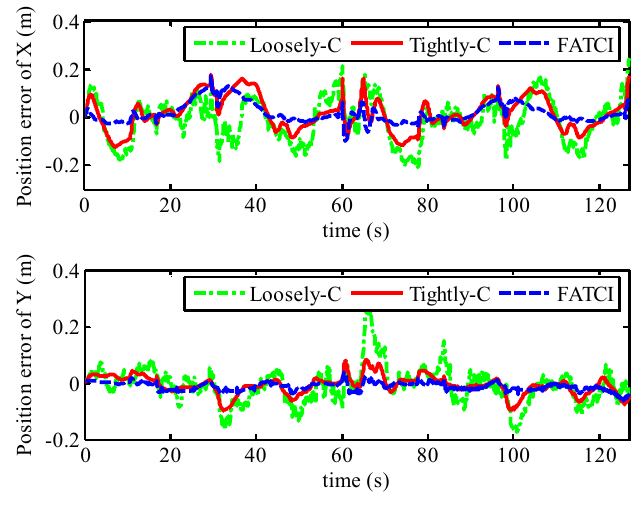
Figure 17. Position error with different integrated methods based on WSN normal conditions.